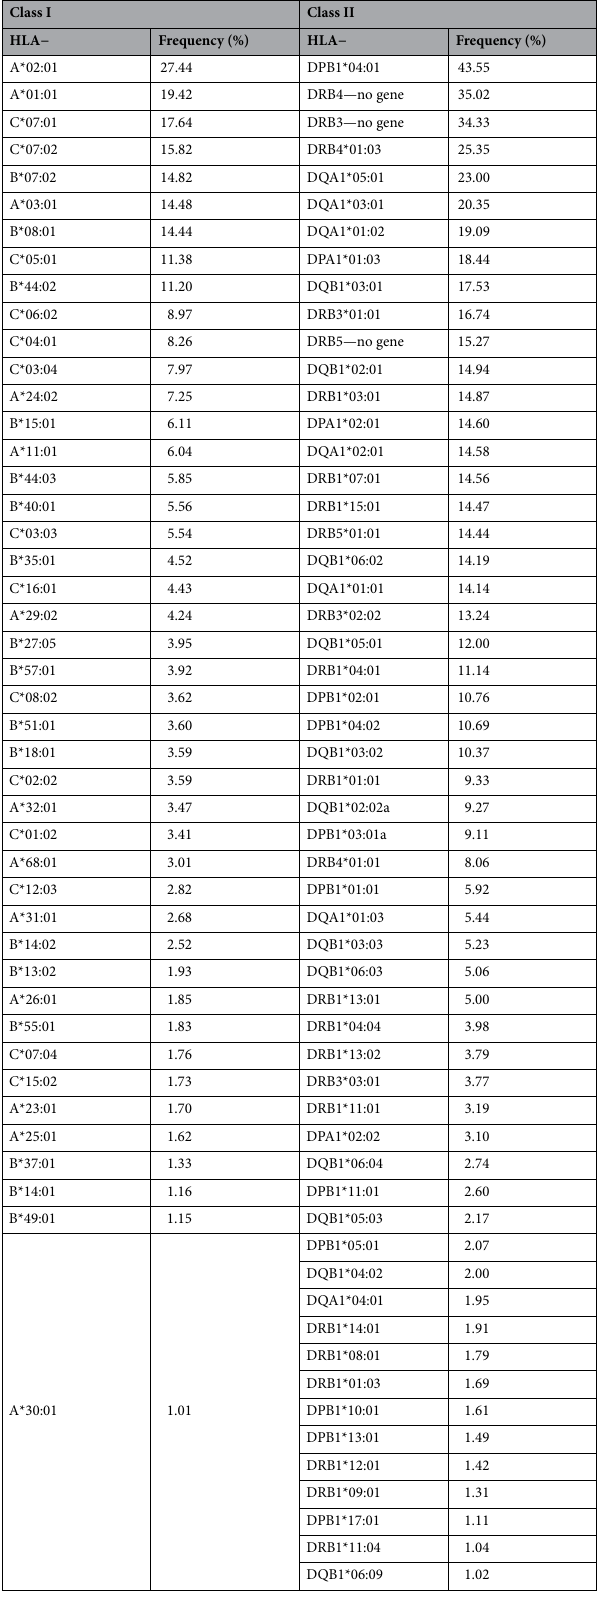
Table 1. HLA types with frequency > 1%. This shows the 44 Class I and 56 Class II types which have frequency > 1% in the cohort. They are split into Class I and Class II and sorted in descending order of frequency. a Not in Hardy–Weinberg equilibrium so excluded from